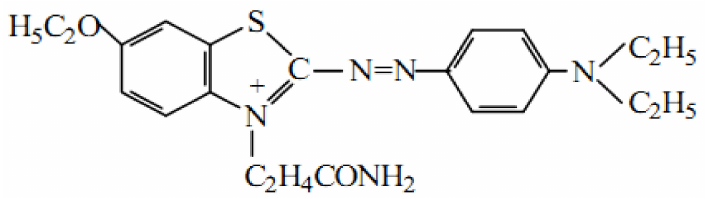
Figure 1. The structure of the cationic orchid X-BL.